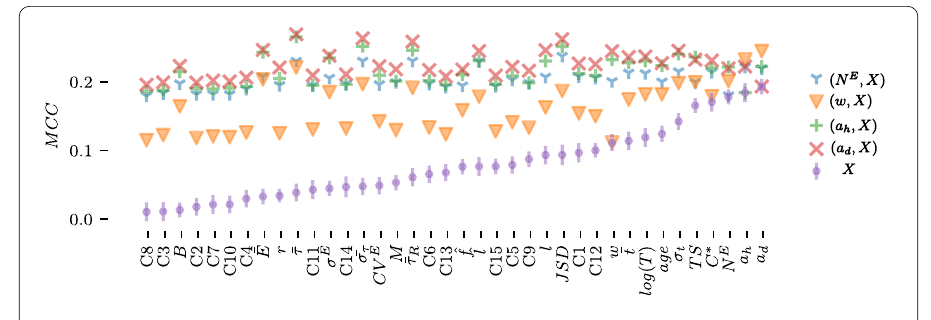
Figure 6 Comparison between single and dual-variable models ( F , X ) for F = N E , w , a h , w d , where we depict the average MCC performance over all overlap cutoff values. For the single-variable case ( X ), error bars are 2 standard deviations, obtained via